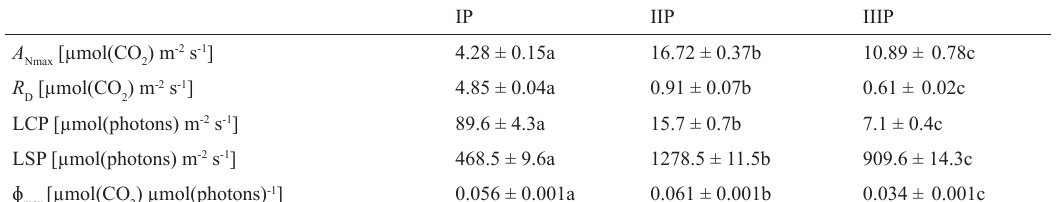
Table 2. Values of maximum net photosynthetic rate [ A µmol(CO ) m -2 s -1 ]; dark respiration rate [ R , µmol(CO ) Nmax, 2 D 2 m -2 s -1 ]; light compensation point [LCP, µmol(photons) m -2 s -1 ]; light saturation point [LSP, µmol(photons) m -2 s -1 ]; maximum quantum yield [ɸ µmol(CO ) µmol(photons) -1 ] in the three phases considered during leaf max, 2 development in Corylus . IP = first phase at developing leaf; IIP = second phase at fully developed leaf; IIIP = third phase at leaf senescence. Different letters indicate significant differences (ANOVA, p ≤ 0.05) among the three phases. Mean values (± SE) are shown (n = 10).